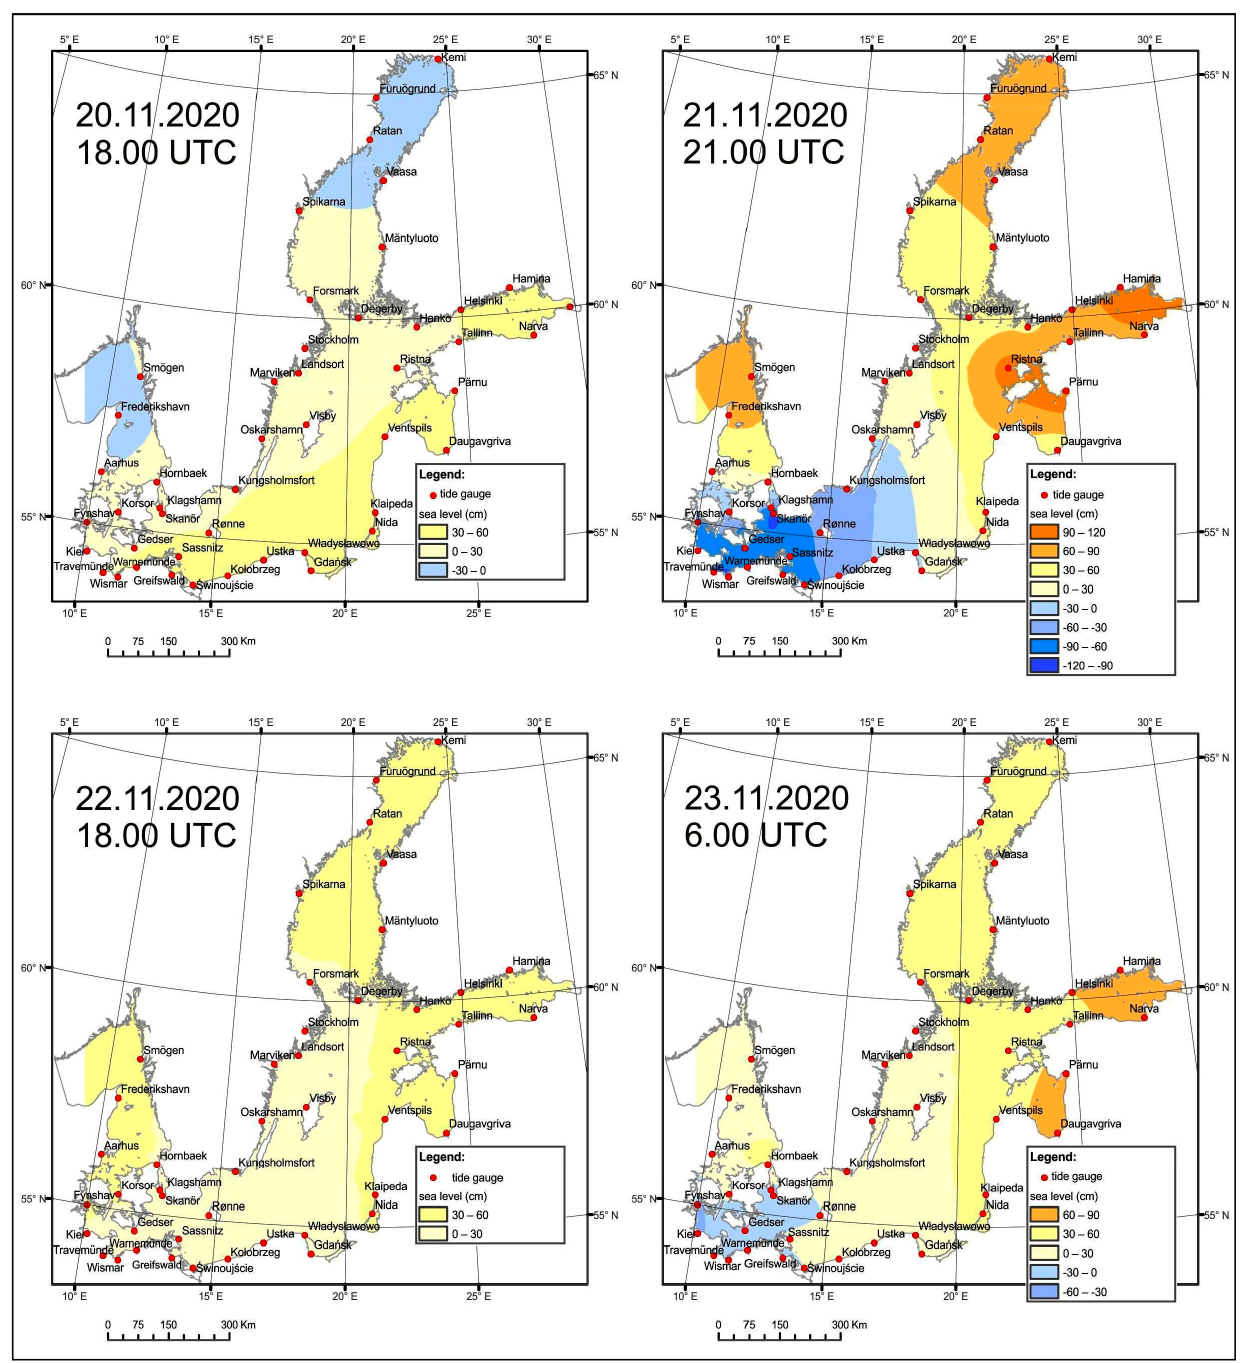
Figure 9. Instantaneous sea levels on the Baltic Sea from 20 to 23 November 2020. (A characteristic phenomenon of alternating sea level oscillations between southwestern and northeastern sub-basins of the Baltic Sea).